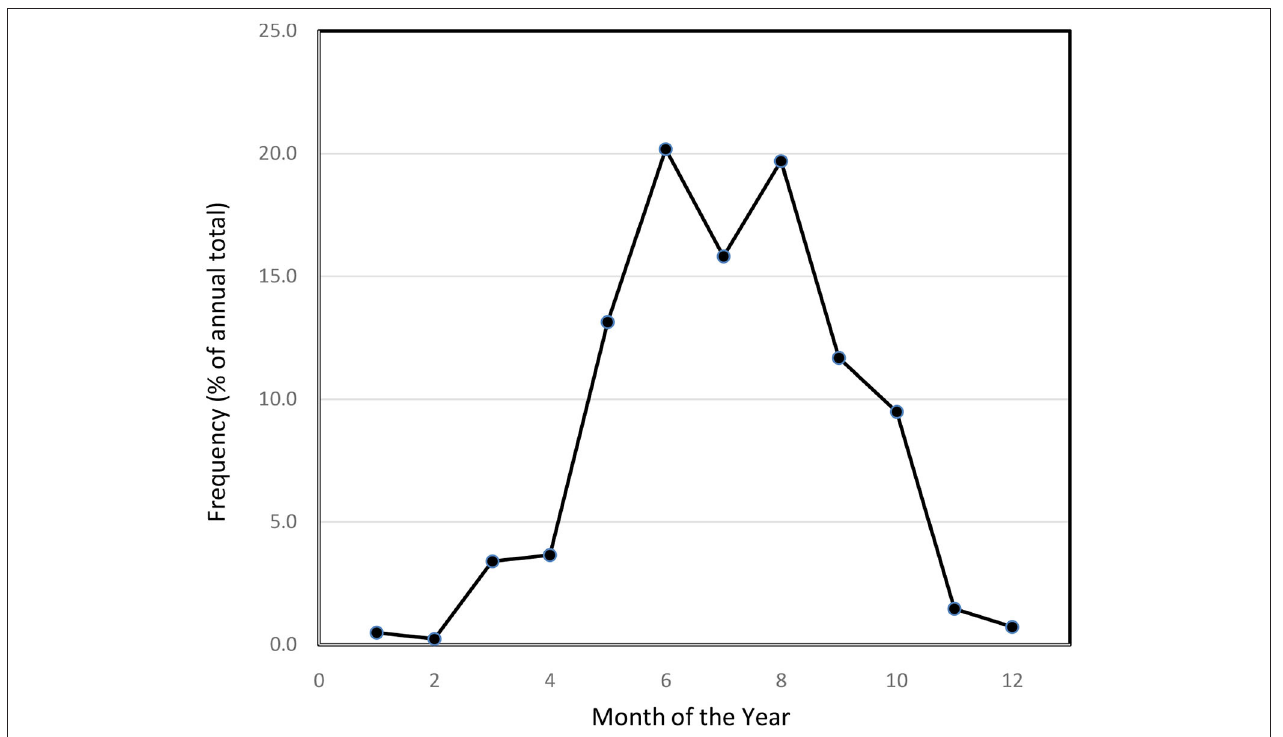
FIGURE 3 | Frequency of runoff events occurring in each month of the year using data from 1958 to